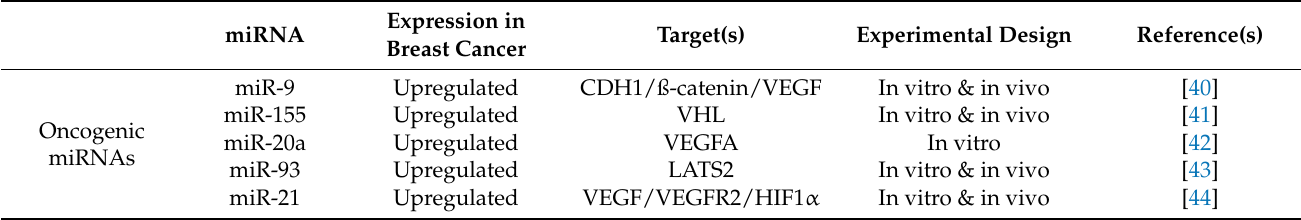
Table 1. miRNAs involved in promoting